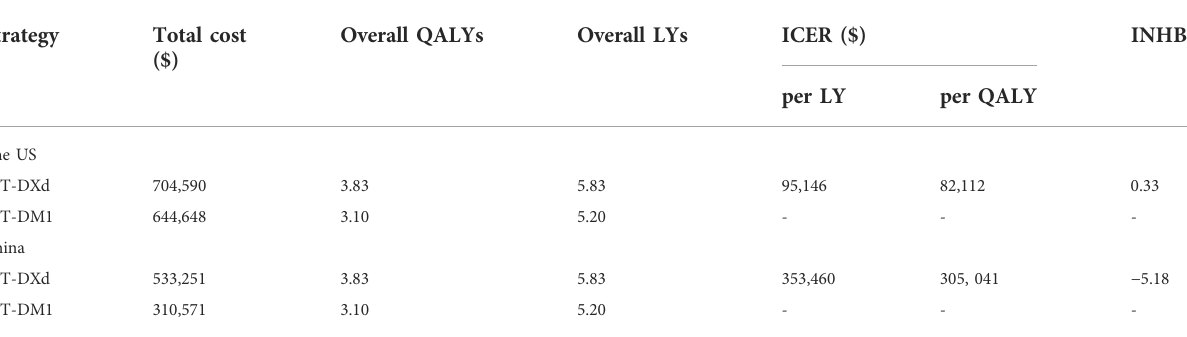
TABLE 3 Base-case results.